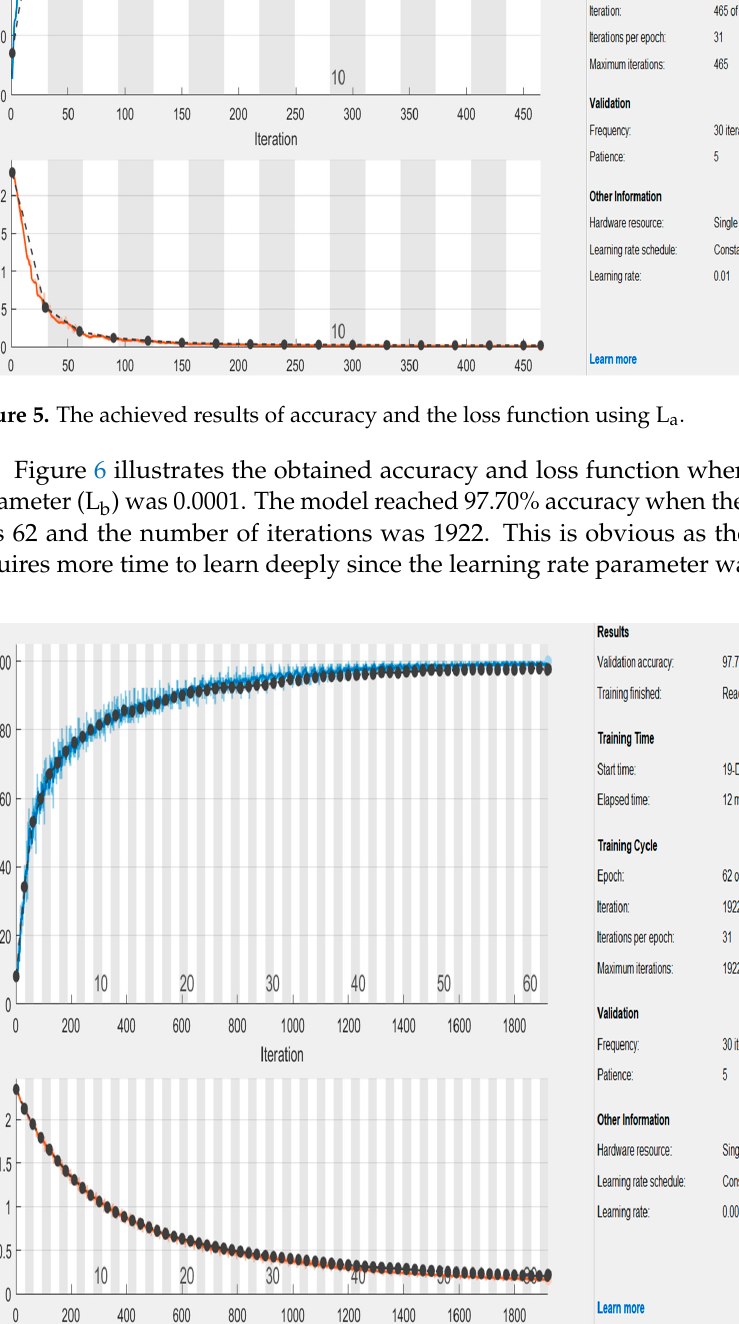
Figure 6. The accomplished graphs of accuracy and the loss function using L b .